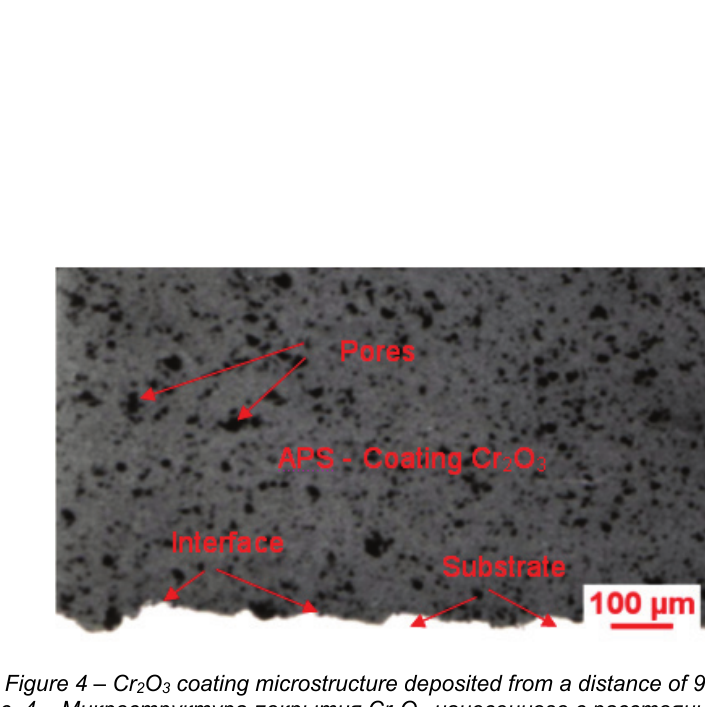
Figure 4 – Cr 2 O 3 coating microstructure deposited from a distance of 90mm Рис . 4 – Микроструктура покрытия Cr 2 O 3, нанесенного с расстояния 90 мм Слика 4 – Микроструктура Cr 2 O 3 превлаке са одстојањем 90 mm